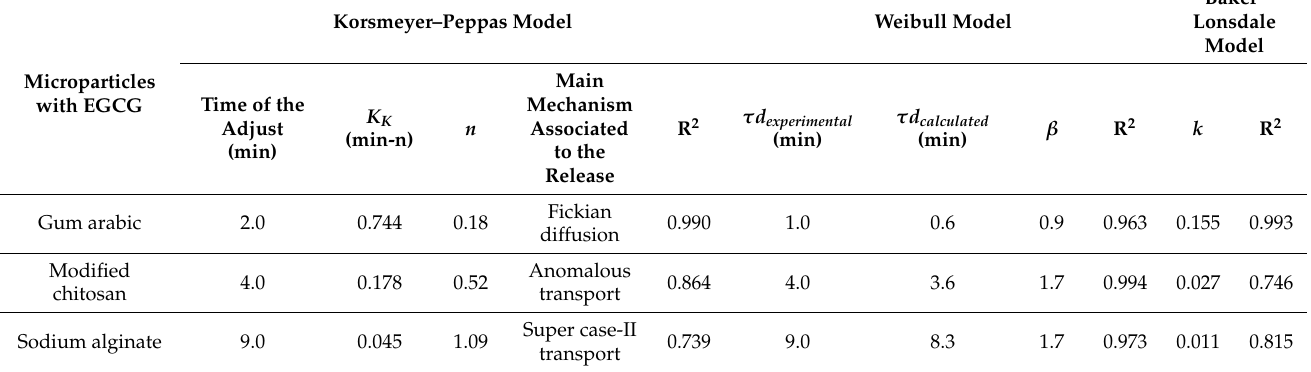
Table 3. Parameters and correlation coefficients of the Korsmeyer–Peppas, Weibull and Baker– Lonsdale models applied to the experimental EGCG release